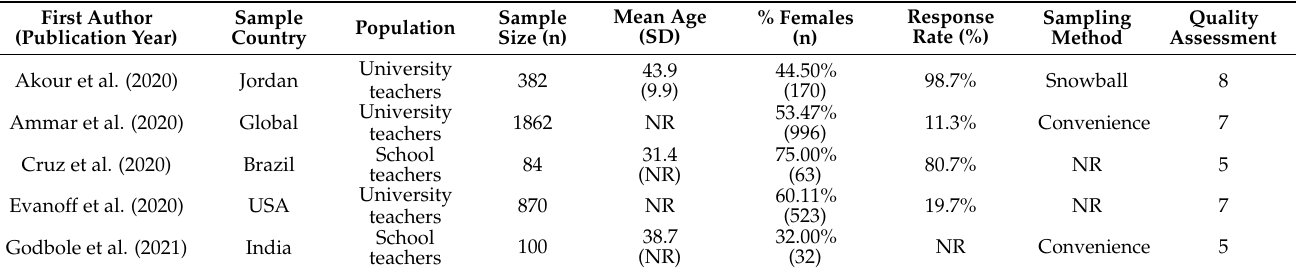
Table 1. Characteristics of the studies included in the